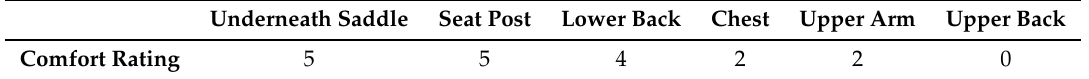
Table 3. Comfort ratings of different tag positions.